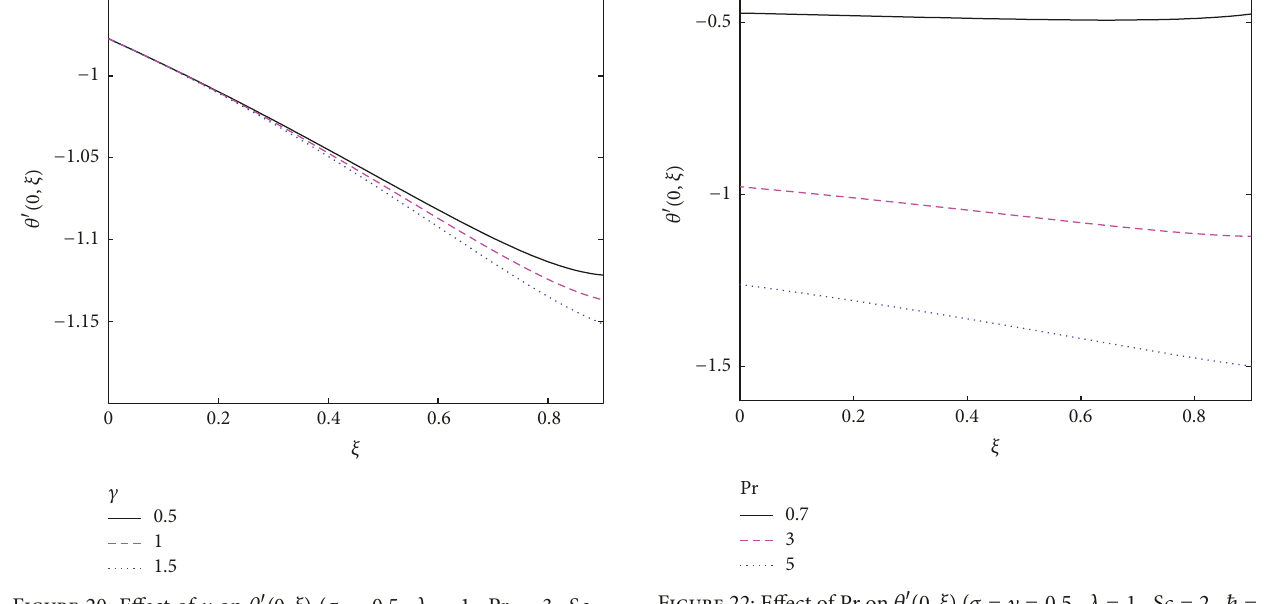
Figure 20: Effect of 𝛾 on 𝜃 󸀠 (0, 𝜉) ( 𝜎 = 0.5, 𝜆 = 1, Pr = 3, Sc = 2, ℏ = −0.5 ).